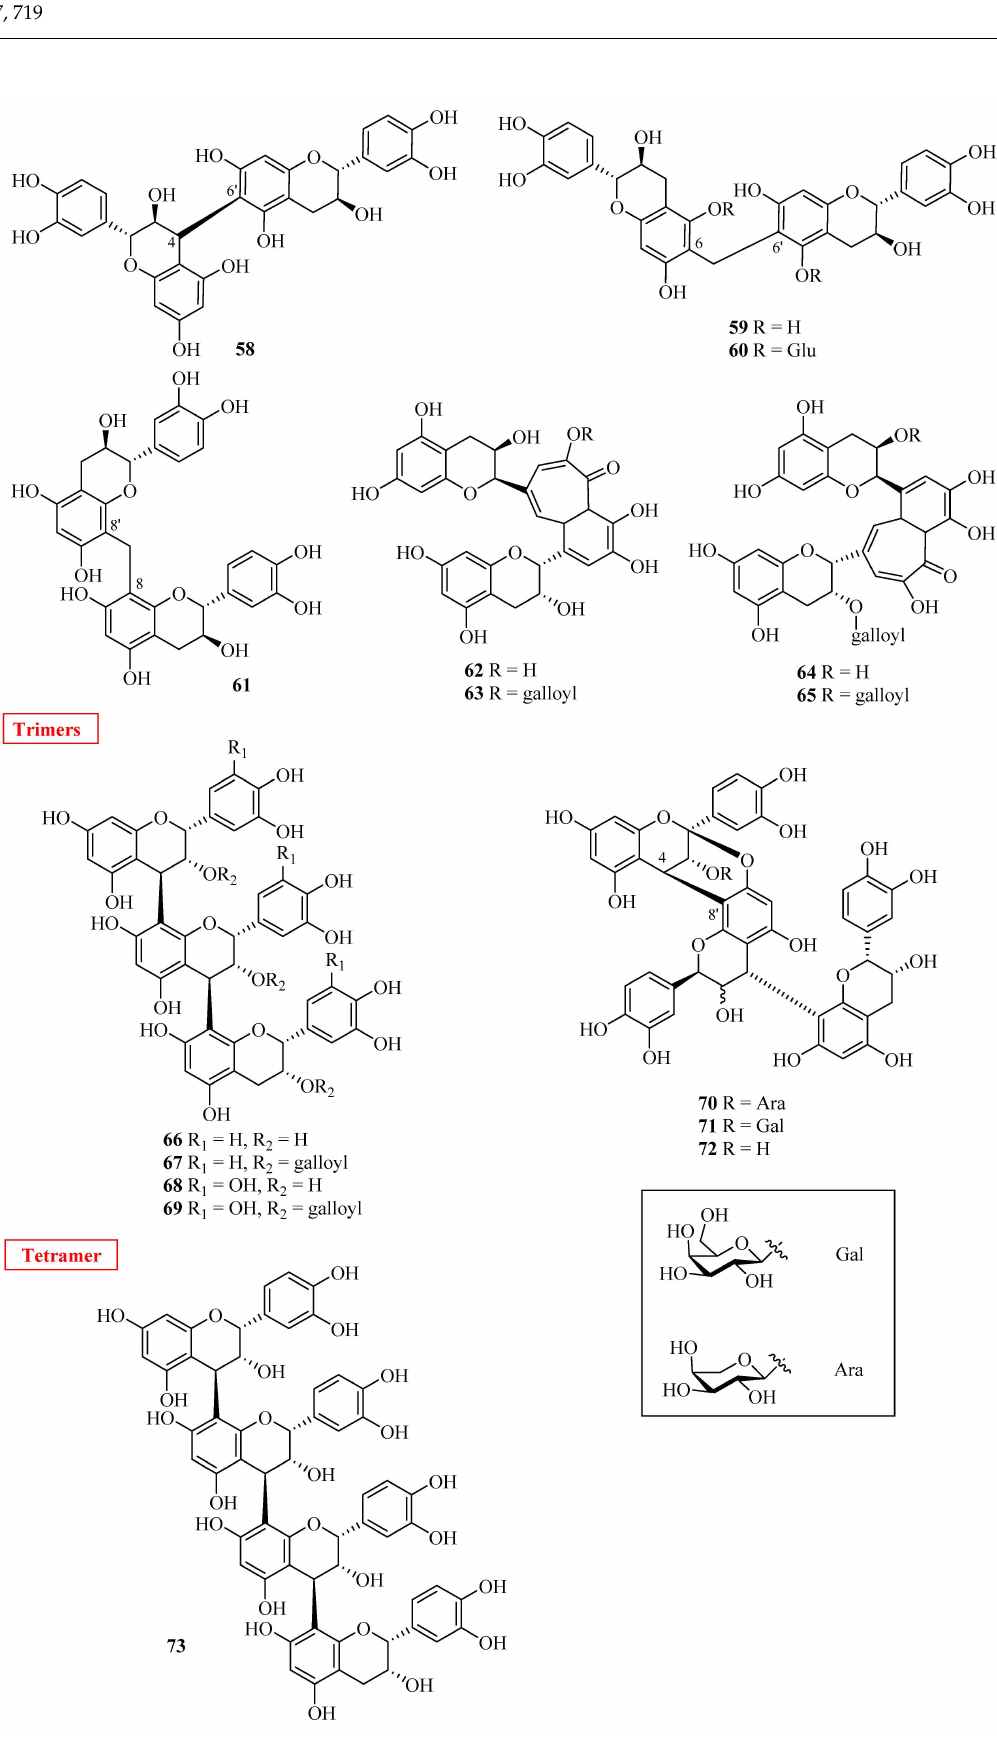
Figure 3. Structures of